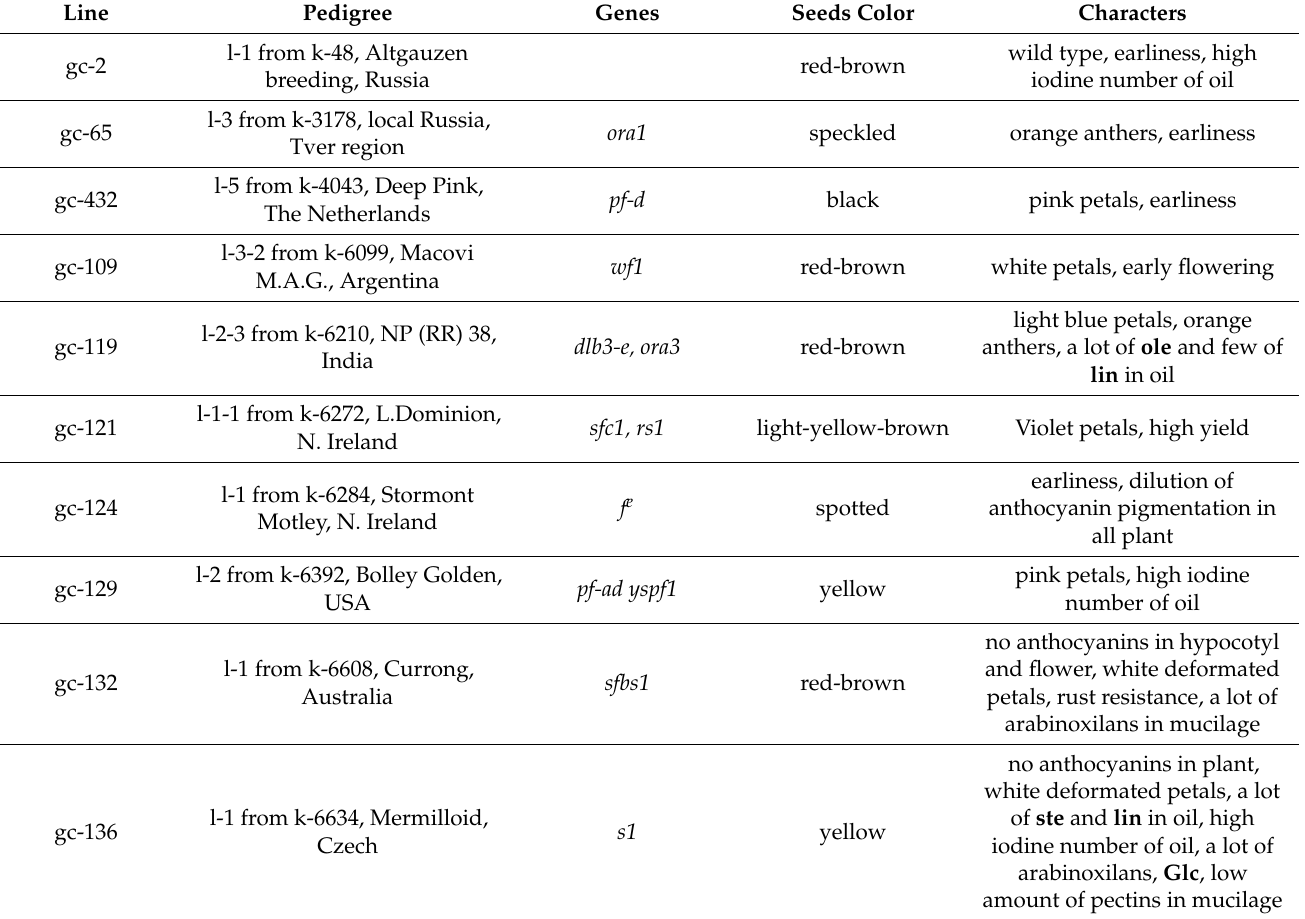
Table 3. Characters of VIR genetic collection